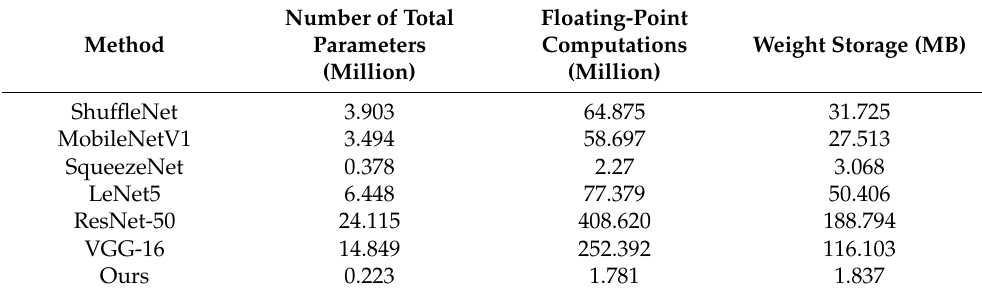
Table 9. Comparison of networks in terms of parameter, weight storage and computational